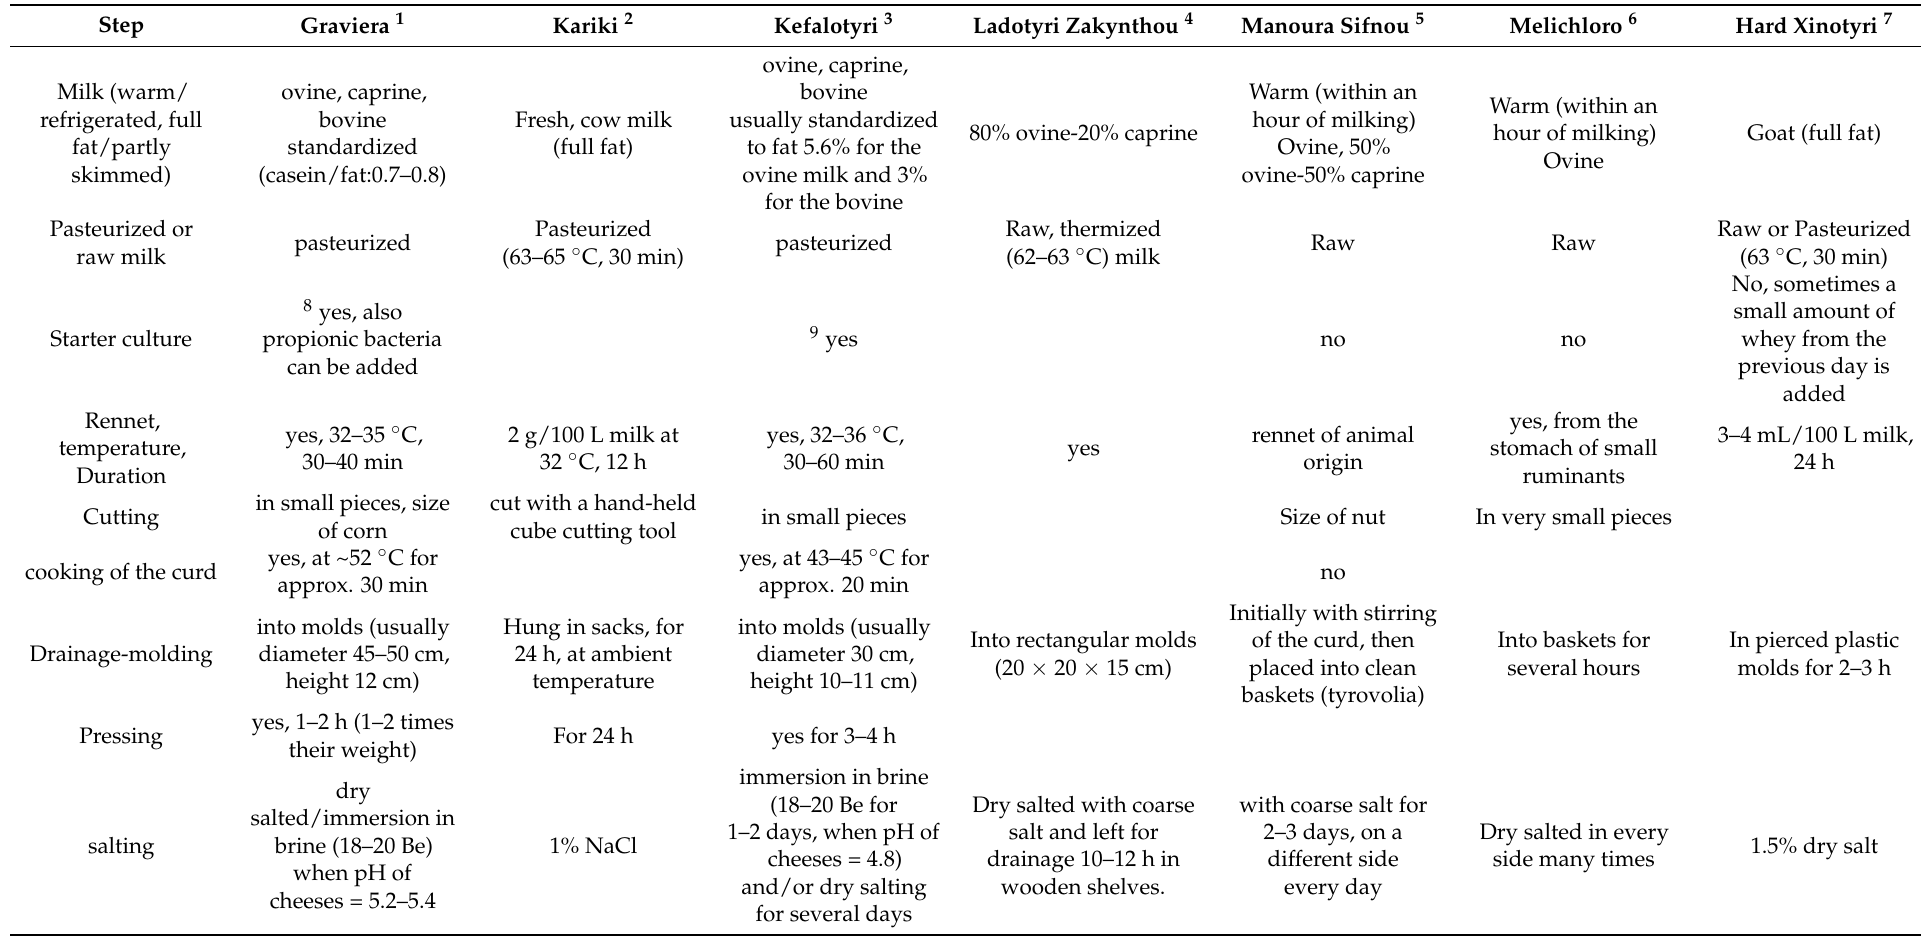
Table 2. Manufacturing technology of nonprotected designation of origin and nonprotected geographical indication hard